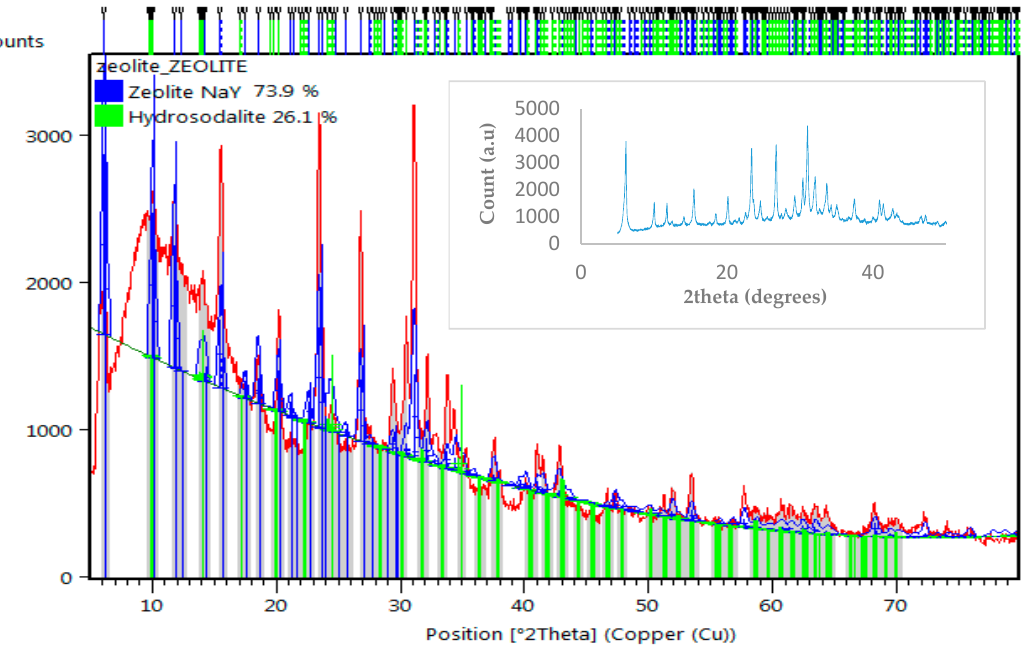
Figure 1. Experimental X-ray diffraction spectrum obtained for zeolite Y. Rietvield analysis confirms 74% zeolite Y phase and 26% hydrosodalite zeolite phase, as shown. The data from the simplified version of the experimental spectrum were plotted and presented as a simplicated spectrum, as shown in the inset.